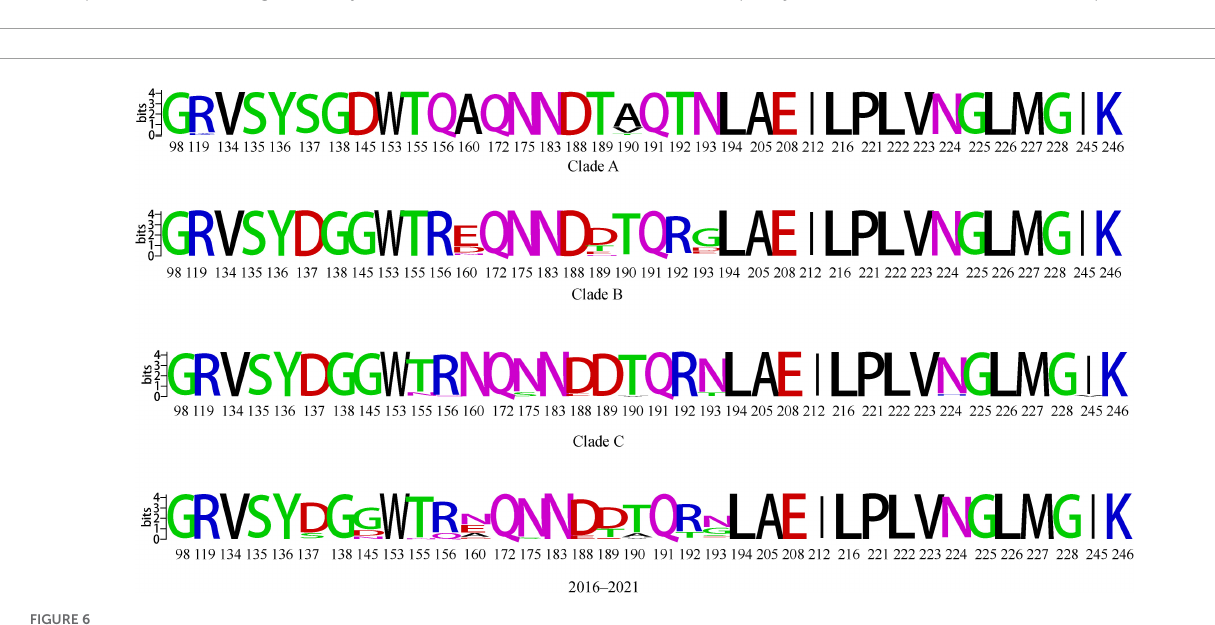
FIGURE5 Conserved amino acid analysis of positive-selection pressure sites for clades A, B and C and 2016–2021 HA genes of H9N2 viruses (Crooks et al., 2004). Each logo consists of stacks of symbols, one stack for each position in the sequence. The overall height of the stack indicates the sequence conservation at that position, while the height of the symbols within the stack indicates the relative frequency of each amino or nucleic acid at that position.